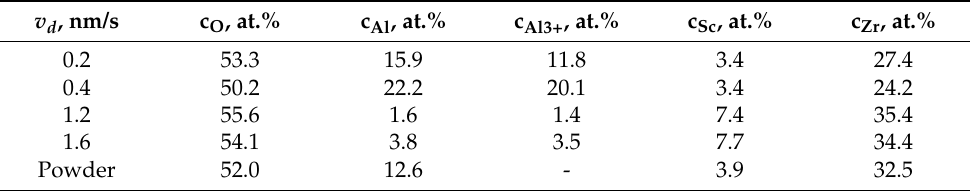
Table 1. EDS analysis results of ScAlSZ thin films deposited on 450 ◦ C substrates ( v d —deposition rate, and c—atomic concentration). v d , nm/s c O ,